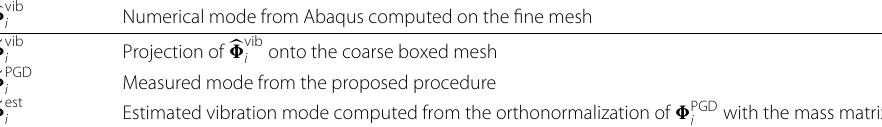
Table 1 Summary of all measured and numerical mode